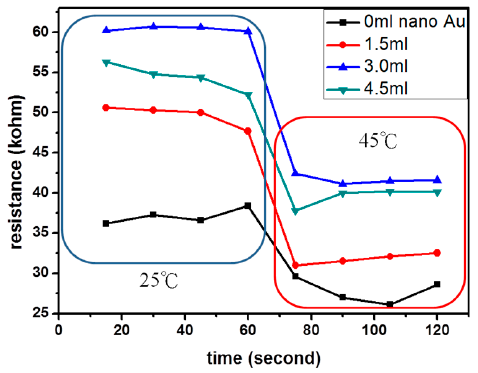
Figure 8. Sensor response of sensor devices containing Black—0 mL; Red—1.5 mL; Blue—3.0 mL; and Green—4.5 mL AuNPs between 25 °C and 45 °C over a period of 2 min.